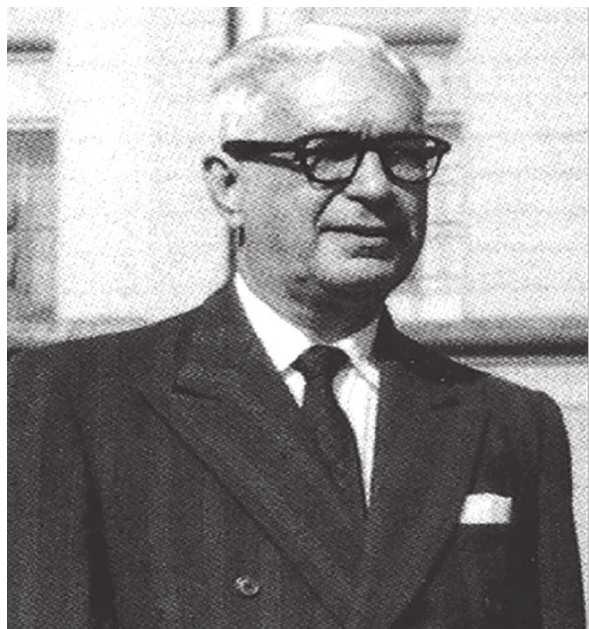
Fig. 3 – Prof. Dr. Alípio Corrêa